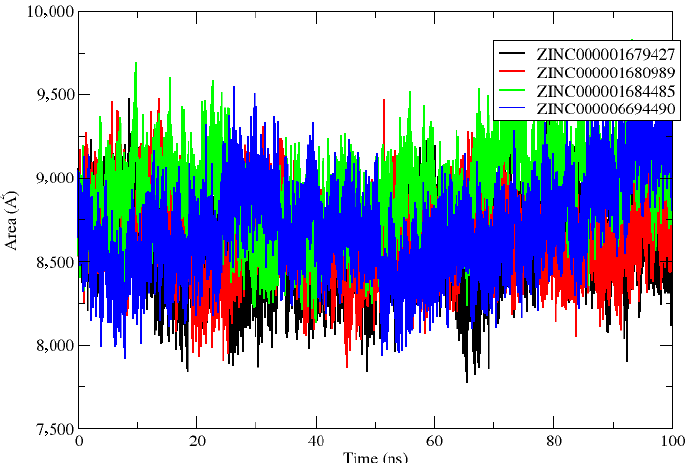
Figure 6. Solvent surface accessible area (SASA) of the NS2B/NS3pro ZINC000001679427 (black line), ZINC000001680989 (red line), ZINC000001684485 (green line) and ZINC000006694490 (blue line) complexes studied.